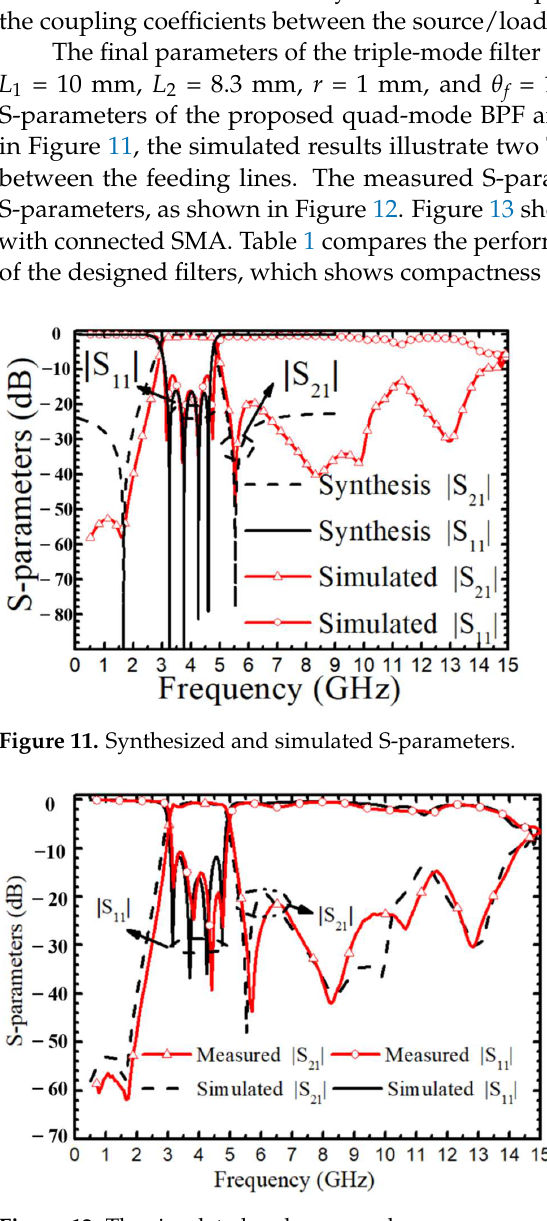
Figure 13. The fabricated filter. Table 1. Comparison with the related references. Ref.